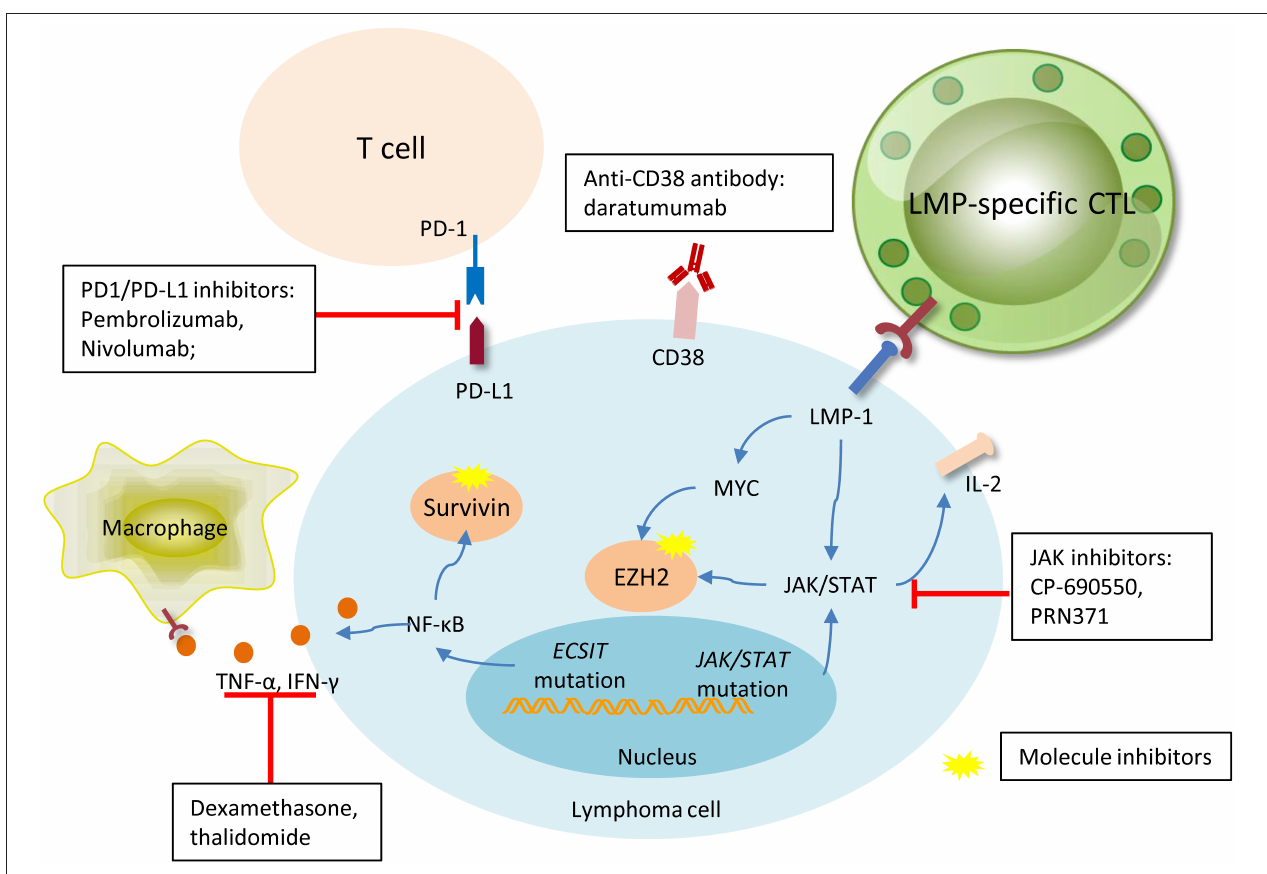
FIGURE 2 | Promising new drugs or treatment strategies in NK/T cell lymphoma and their target. Pembrolizumab and nivolumab are both anti-PD1 antibodies, they were designed to target PD1 on the microenvironment T-cells, interrupting the connection of PD1 and PDL-1, and inhibiting activation. Daratumumab, a novel antibody targeting CD38 on the membrane of lymphoma cell, has shown particular efficacy in one case. LMP-specific CTLs are produced against lymphoma cells with membrane expression of LMP, and sequentially kill tumor cells. Signal pathways aberration and gene dysregulation are universally involved in lymphomagenesis, thus making molecule inhibitors an attractive target. JAK inhibitors, surviving, and EZH2 blocades have shown efficacy in some pre-clinical trials with favorable outcomes. The immunosuppressive agents, dexamethasone, and thalidomide, can efficaciously inhibit the TNF- α and IFN- γ released by lymphoma cells due to the ECSIT mutation, and relieve ENKL-associated hemophagocytic